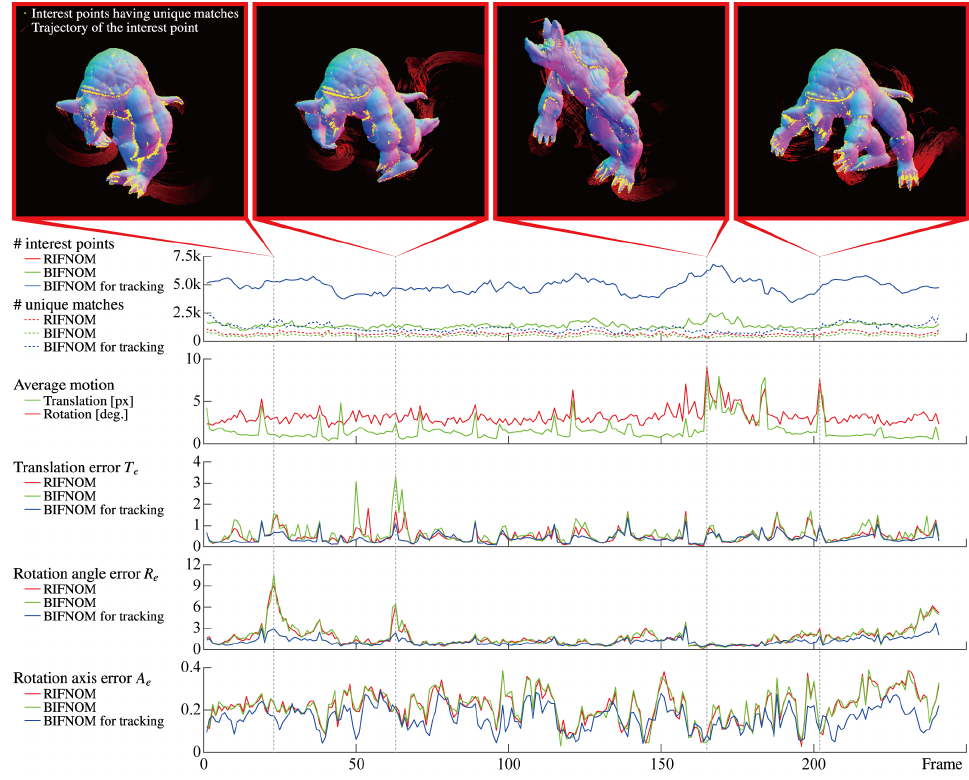
Figure 6. Estimated motion from sequential images of a non-rigid body model, “Armadillo”. The graph of the number of interest points for RIFNOM is the same as for